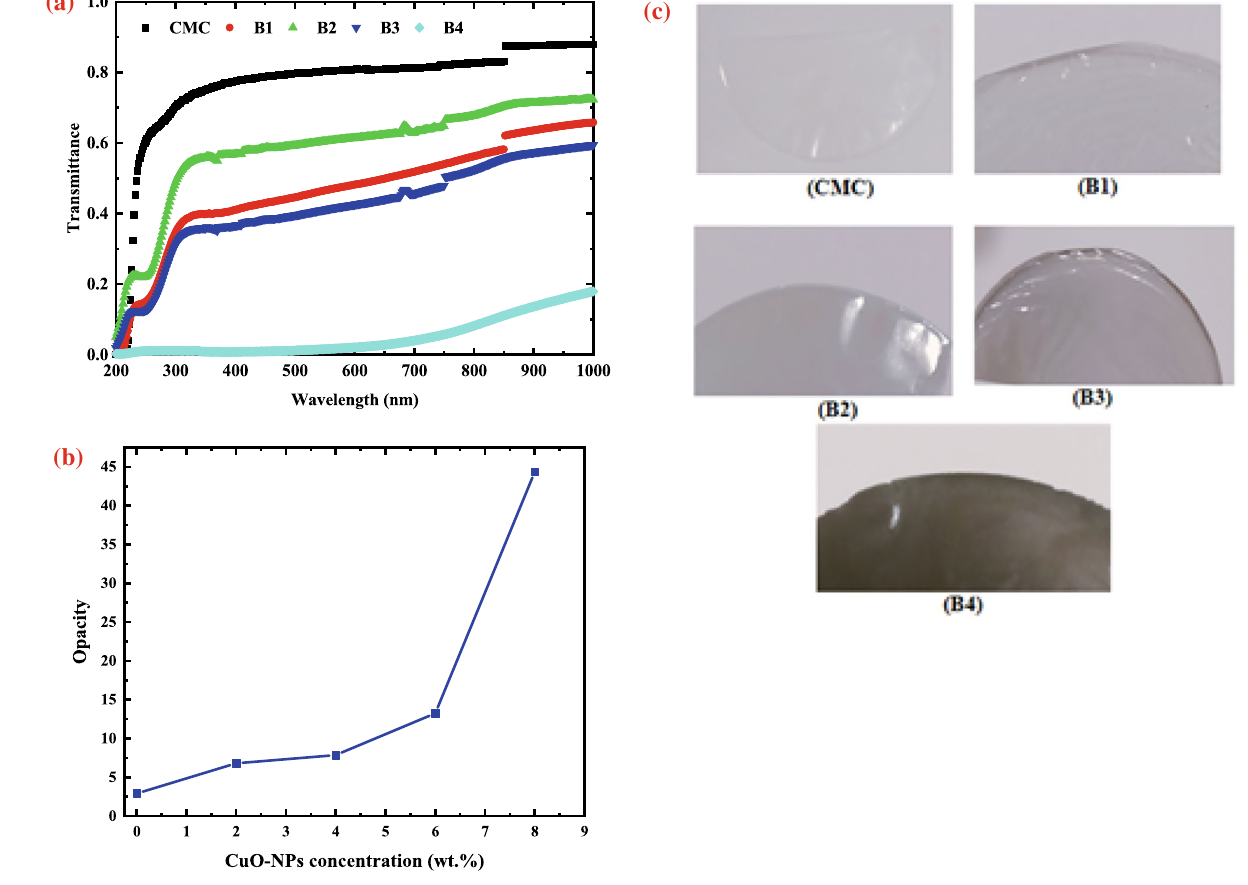
Figure 4. ( a ) UV/Vis-Transmittance spectra for pure CMC and CMC loaded with (2, 4, 6 and 8 wt.% CuO- NPs), ( b ) variation of opacity with CuO concentration and (c) visual examination of CMC/CuO nanocomposite films. CMC loaded with CuO-NPs